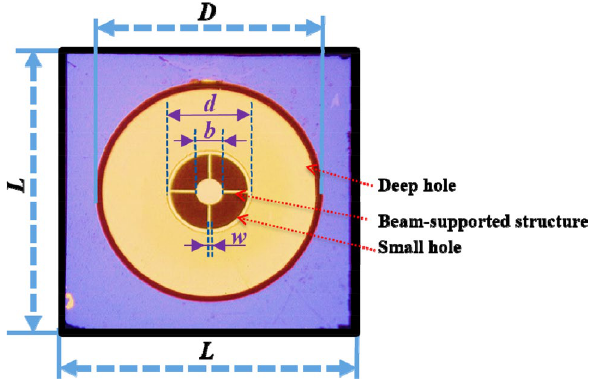
Figure 2. The microscopic photo of the beam-supported diaphragm.